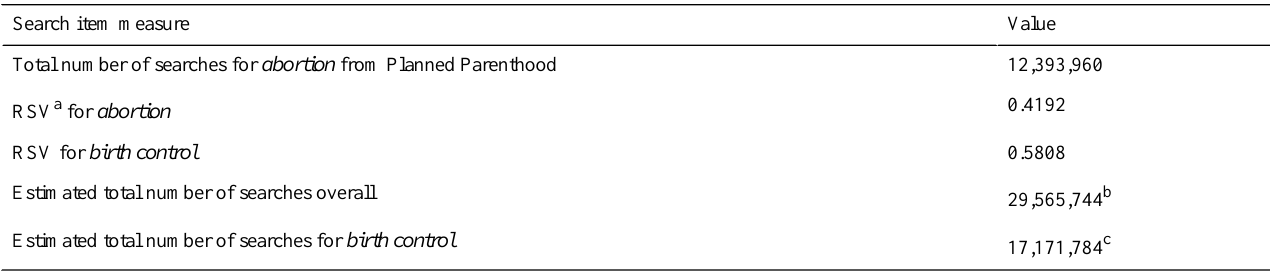
29,565,744 b Estimated total number of searches overall